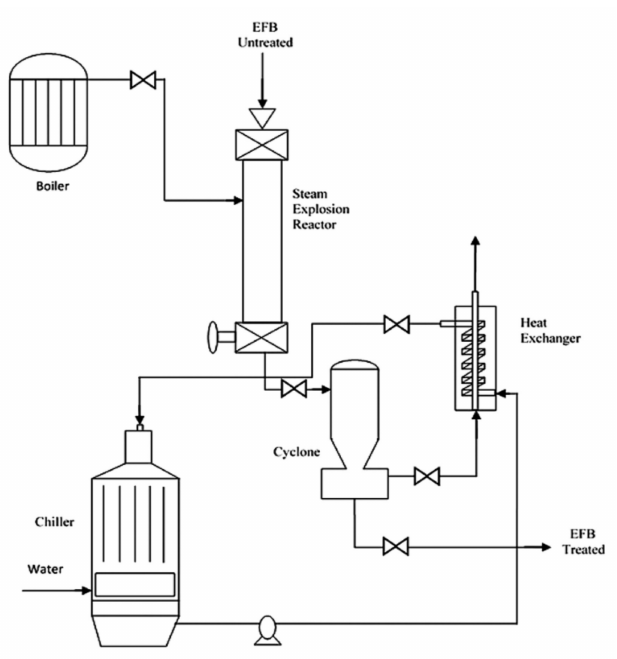
Figure 5. Schematic diagram of steam explosion process. Page: 11 Reprinted with permission from ref. [51]. 2016